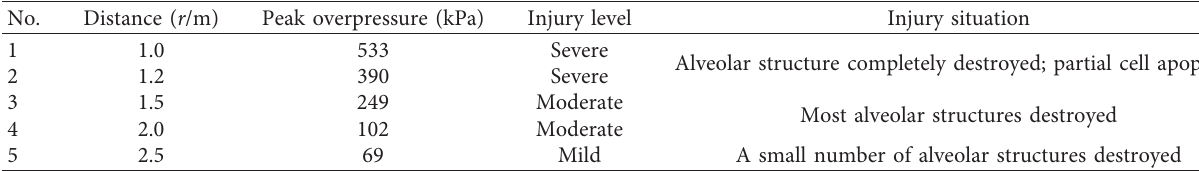
Table 3: Injury of rabbits by blast shock